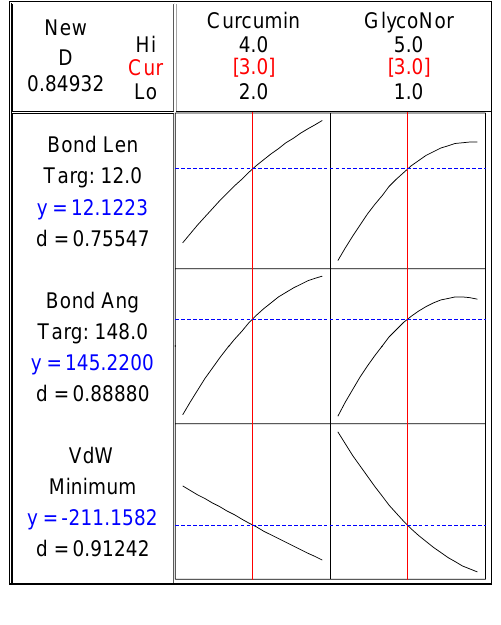
Figure 12. Desirability plots depicting the requisite variables for attributes of optimal combination with the desired targeted